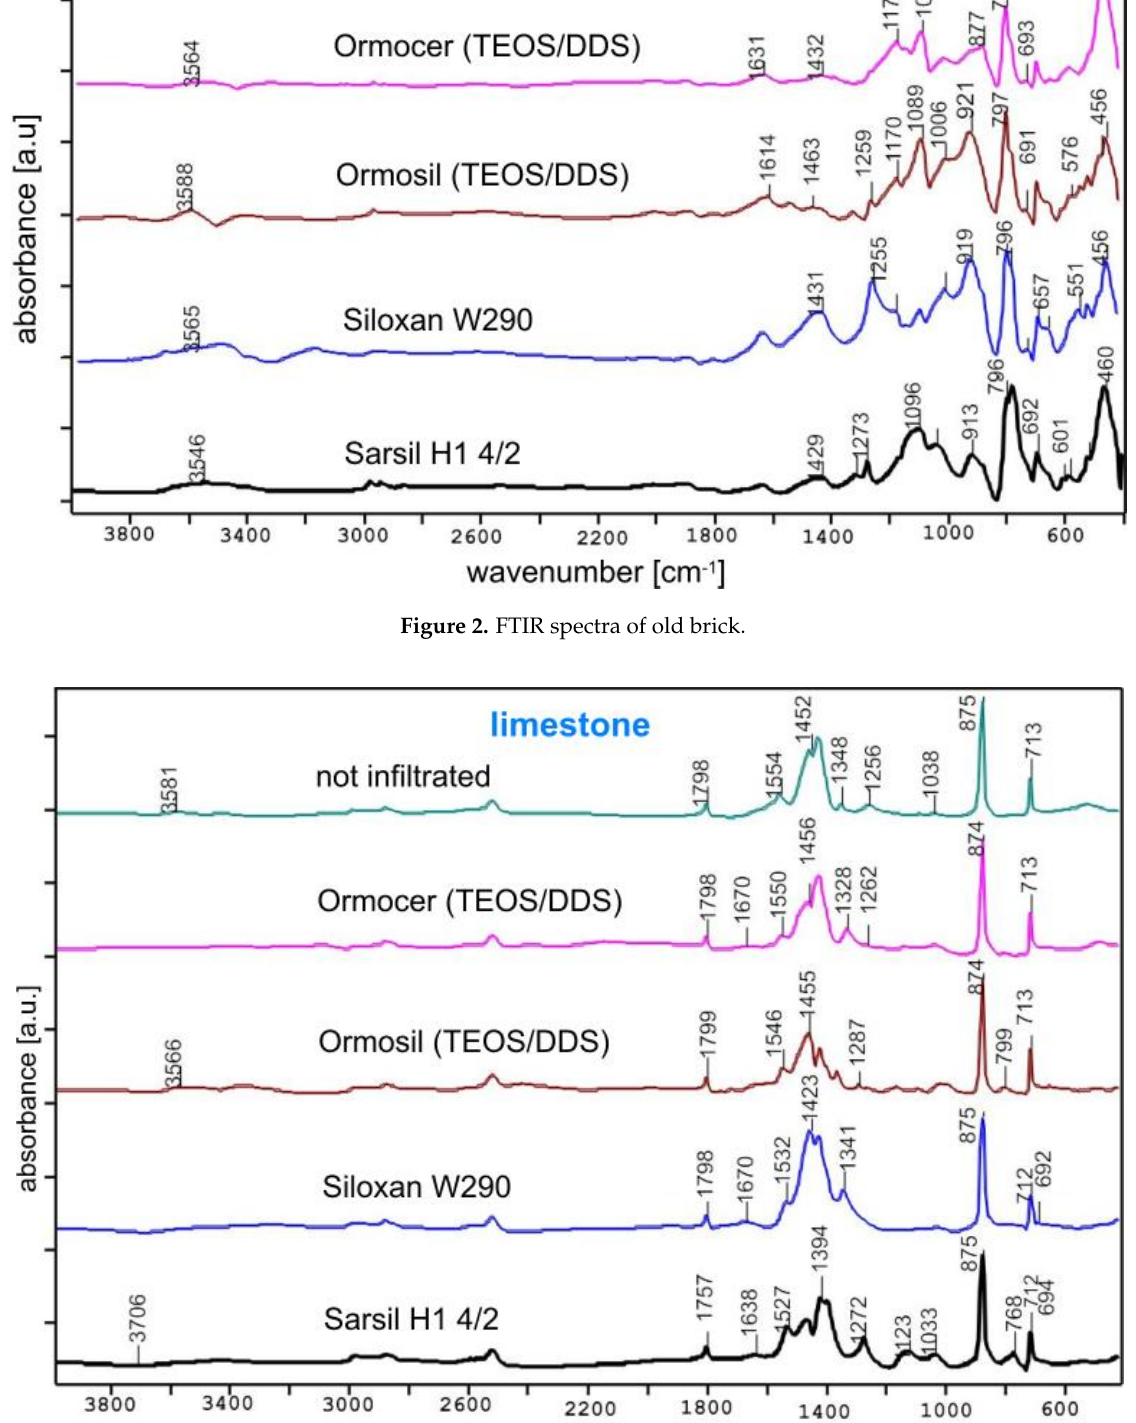
Figure 3. FTIR spectra of the limestone.